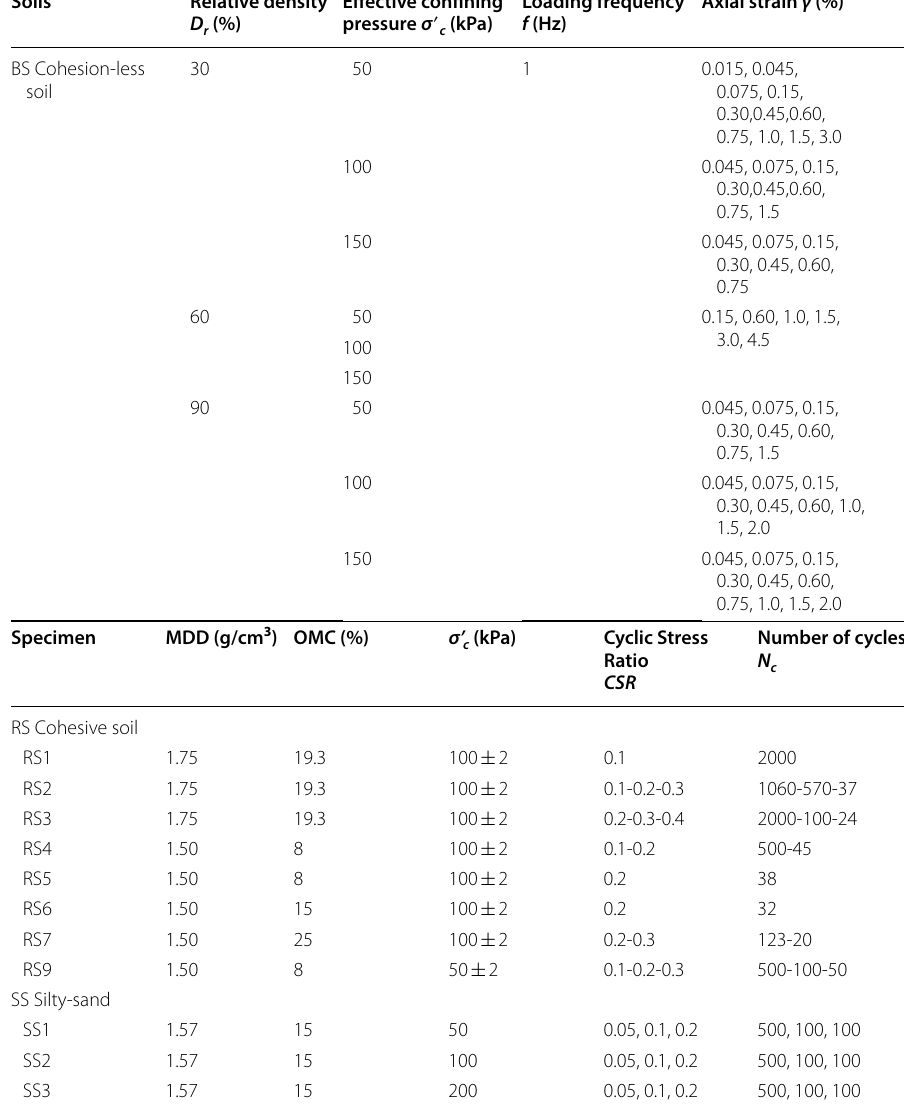
Table 2 Investigating parameters for cohesionless, cohesive and silty-sand soils for the evaluation of dynamic soil properties